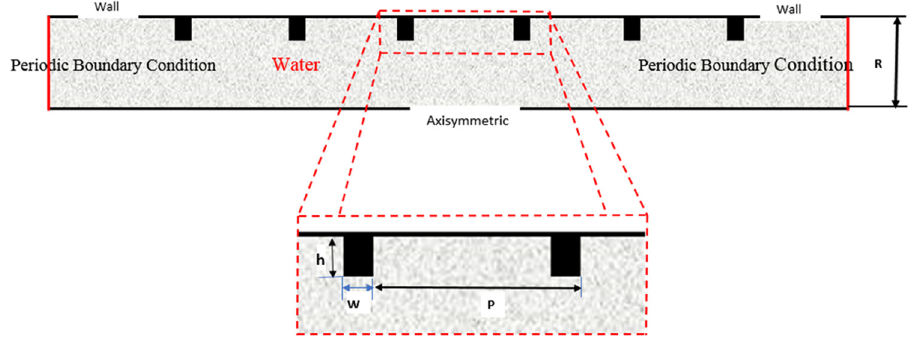
Figure 1: The Schematic of channel geometry and boundary conditions.